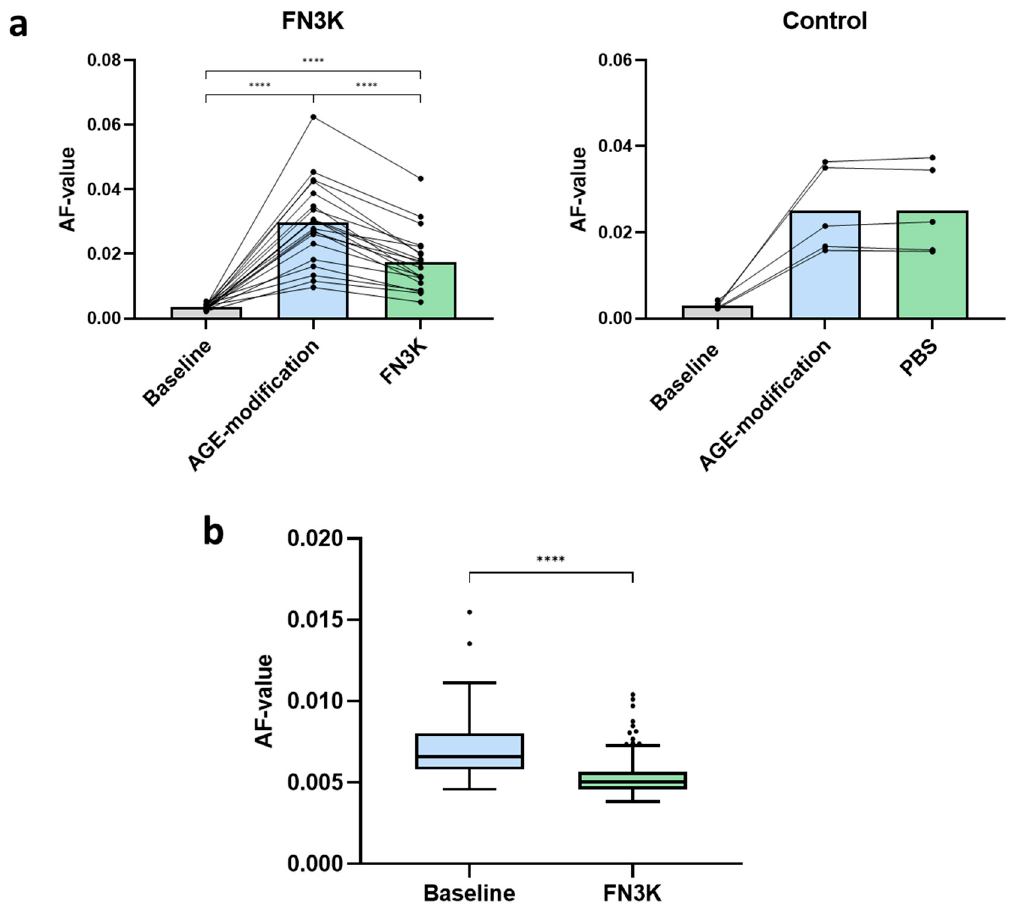
Figure 2. ( a ) Autofluorescence (AF) values of glycolaldehyde-induced advanced glycation end product (AGE)-modified porcine neural retinas after control ( n = 5) and fructosamine-3-kinase (FN3K, n = 20) treatment. The bars represent the mean. PBS = phosphate buffered saline. ( b ) Box-and-whisker plot illustrating AF-values at 30 different retinal locations of four different post-mortem human neural retinas from stage 1 ( n = 3) and stage 2 ( n = 1) AMD patients at baseline ( n = 120) and after treatment with FN3K ( n = 120). **** P < 0.0001.